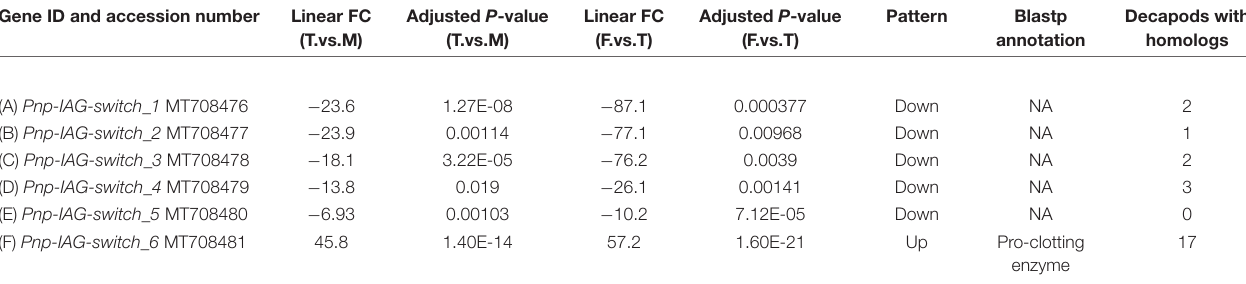
TABLE 1 | AG differentially expressed genes correlated with Pnp-IAG transcriptional pattern throughout the P. platyceros life-history. Gene ID and accession number Linear FC